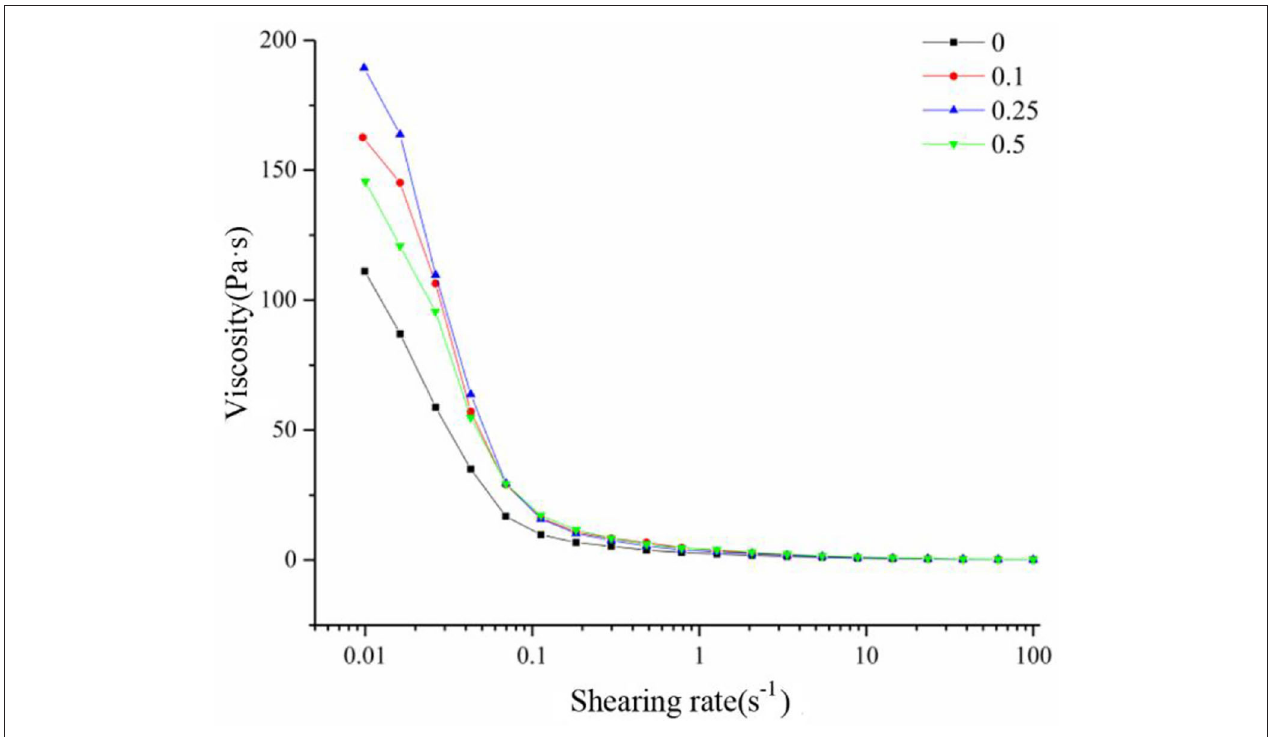
FIGURE 9 | Static rheological diagram of